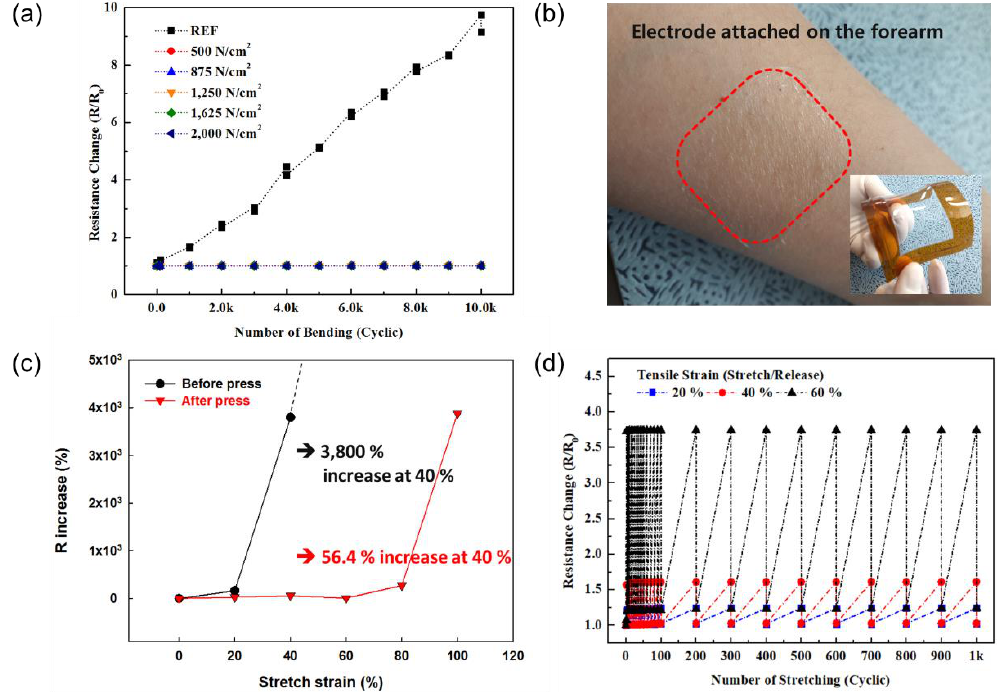
Figure 8. Flexibility and stretchability of the AgNW electrode embedded in PDMS where ( a ) shows the change in sheet resistance during the cyclic bending (radius = 3 mm) for various pressure conditions (detailed resistance changes for each condition can be found in Figure S2, Supporting Information); ( b ) an optical image of an Ag nanomesh skin electrode, invisible to the naked eye, obtained by attaching 2D Ag nanomesh-embedded PDMS to human skin; ( c ) the change in sheet resistance of the AgNW-embedded PDMS before (with the 3D AgNW network) and after (with the 2D Ag nanomesh) pressurizing at 2000 N / cm 2 , measured as a function of stretch strain; ( d ) the e ff ect of repeated stretching and releasing on the resistance (stretch / release cycles of tensile strain = 20%, 40%, and